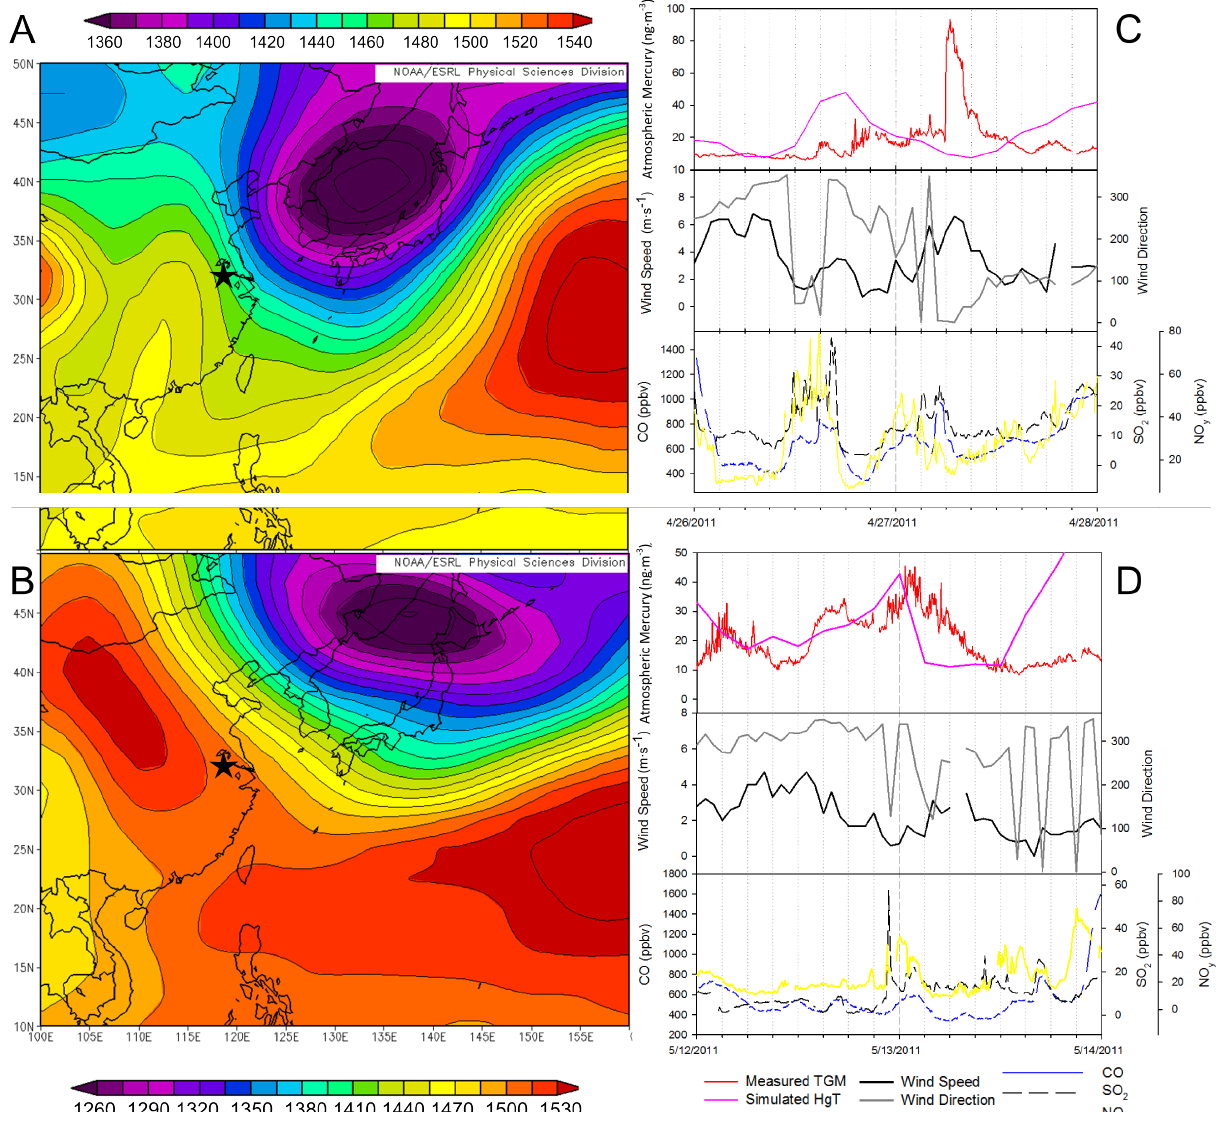
Figure 16. The geopotential height at 850 hPa over East Asia from NCEP/NCAR reanalysis for ( A ) 27 April 2011 and ( B ) 13 May 2011. A time series of measured TGM (red), Flexpart simulated TGM (magenta), wind speed (black), wind direction (grey), CO (blue), NO (yellow), and SO (black dash) for ( C ) 26 and 27 April 2011, ( D ) 12 and 13 y 2 May 2011. The star (  ) indicates the location of